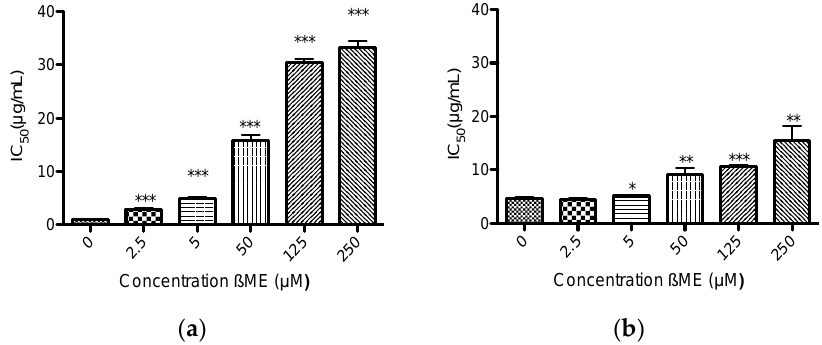
Figure 6. The reversal of trypanocidal effect in Trypanosoma brucei brucei by ( a ) garlic and ( b ) onion extracts after addition of β-mercaptoethanol. The values are expressed as mean IC 50 (μg/mL) ± SD. P values are interpreted as: * p ≤ 0.05; ** p ≤ 0.01; *** p ≤ 0.001.